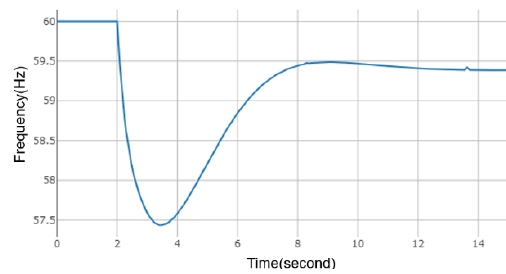
Figure A3. N-1 contingency frequency at 9th hour of 3rd ED.